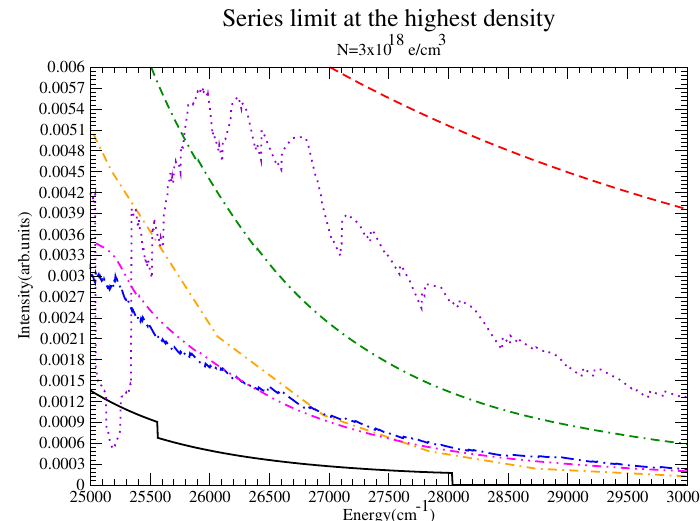
Figure 22. The region near the series limit at the highest density. Shown are QC-FFM (solid), PPP (dashed), DWE (dash-dotted), CONVST without strong collisions (dotted), CONVST with strong collisions (dot-double dashed), CONVPST without strong collisions (long dash-dotted) and CONVPST with strong collisions (dash-double dotted).